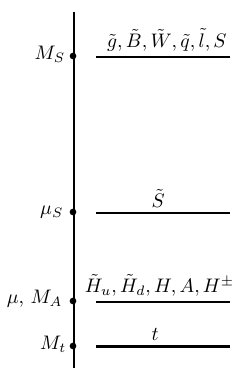
Figure 1 . Schematic representation of hierarchy among the various mass scales in the